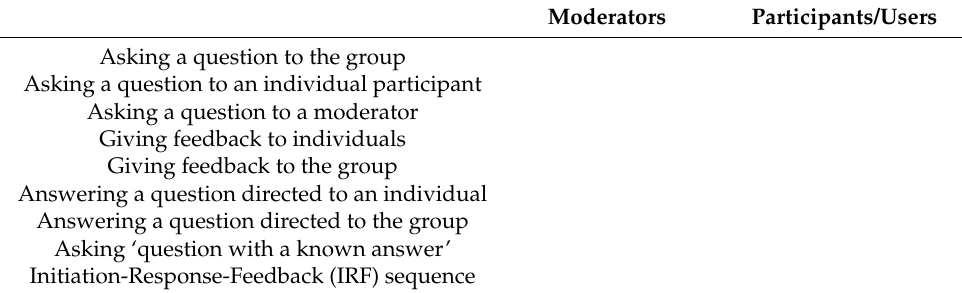
Table 3. Coding framework for educational actions.